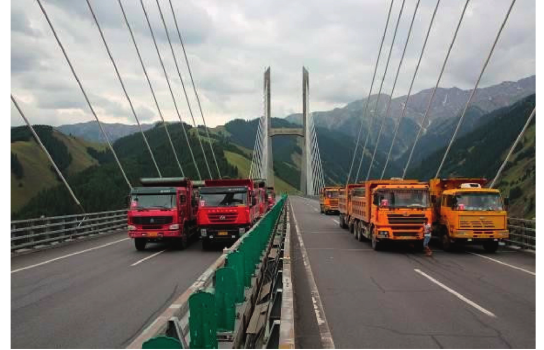
Figure 8: Live load test.